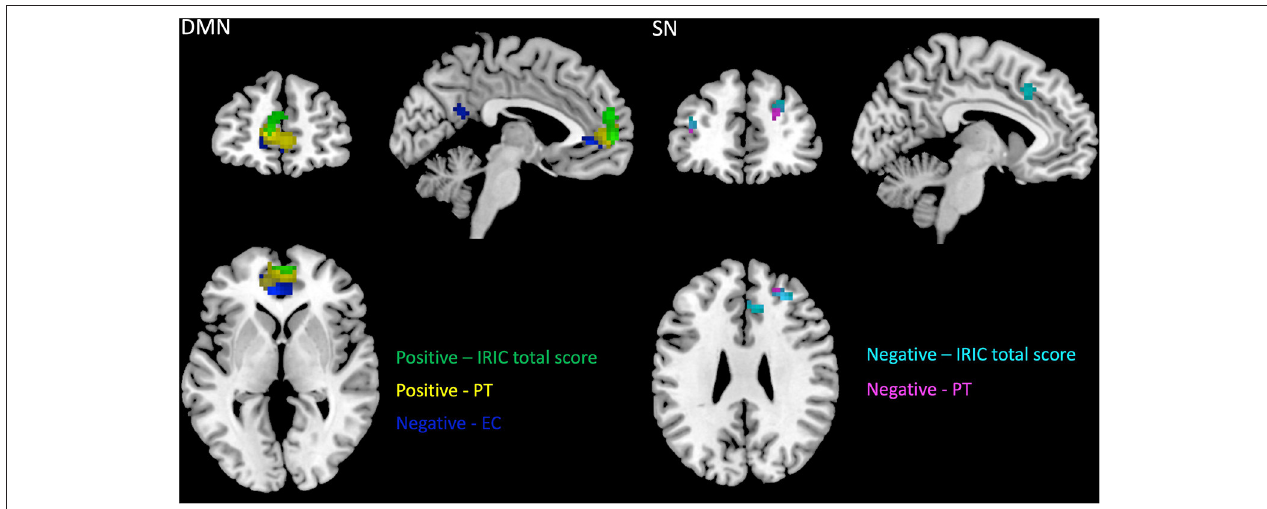
FIGURE 5 | Correlations between DMN and SN functional connectivity and IRIC scores. p < 0.05 corrected for multiple comparisons, extent threshold of k = 54 voxels for DMN and k = 35 for SN. IRIC, Interpersonal Reactivity Index for Couples; PT, dyadic perspective taking subscale; EC,dyadic empathic concern subscale.